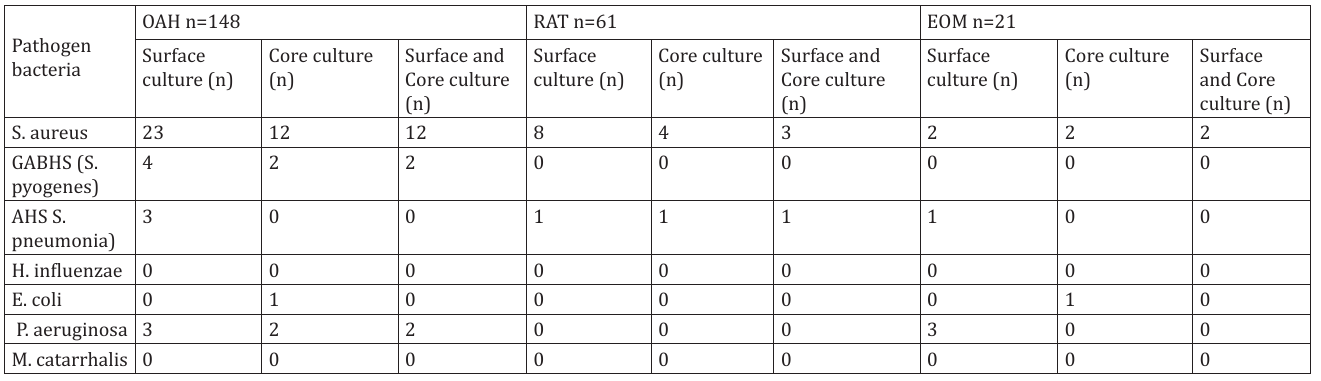
Pathogenic microflora isolated from the adenoids of all three groups.